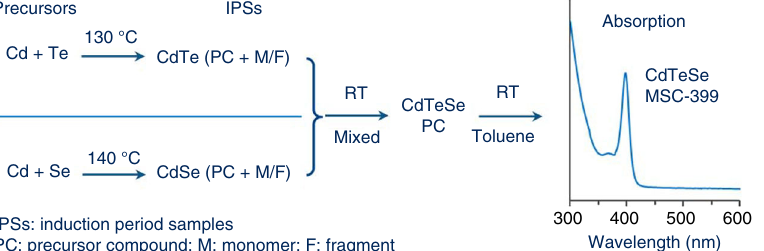
Fig. 1 Schematic outlining the synthesis of alloy CdTeSe MSC-399 and formation hypothesis. The alloy MSCs are prepared at room temperature from the mixture of the two induction period samples (IPSs) of binary CdTe and CdSe (Equation (1)). Cd and Te or Cd and Se precursors are independently mixed at room temperature and heated at ~130 or ~140 °C to prepare the IPS, which has the precursor compounds (PCs) of CdTe MSC-371 or CdSe MSC-415, respectively, together with corresponding monomers (M) and fragments (F). The binary samples are mixed at room temperature for a period of time to produce MSC-399 via its precursor compound (CdTeSe PC, (Equation (4)), which is proposed to form via substitution reactions of the CdTe PC with the CdSe monomers and fragments (Equation (2)), and of the CdSe PC with the CdTe monomers and fragments (Equation